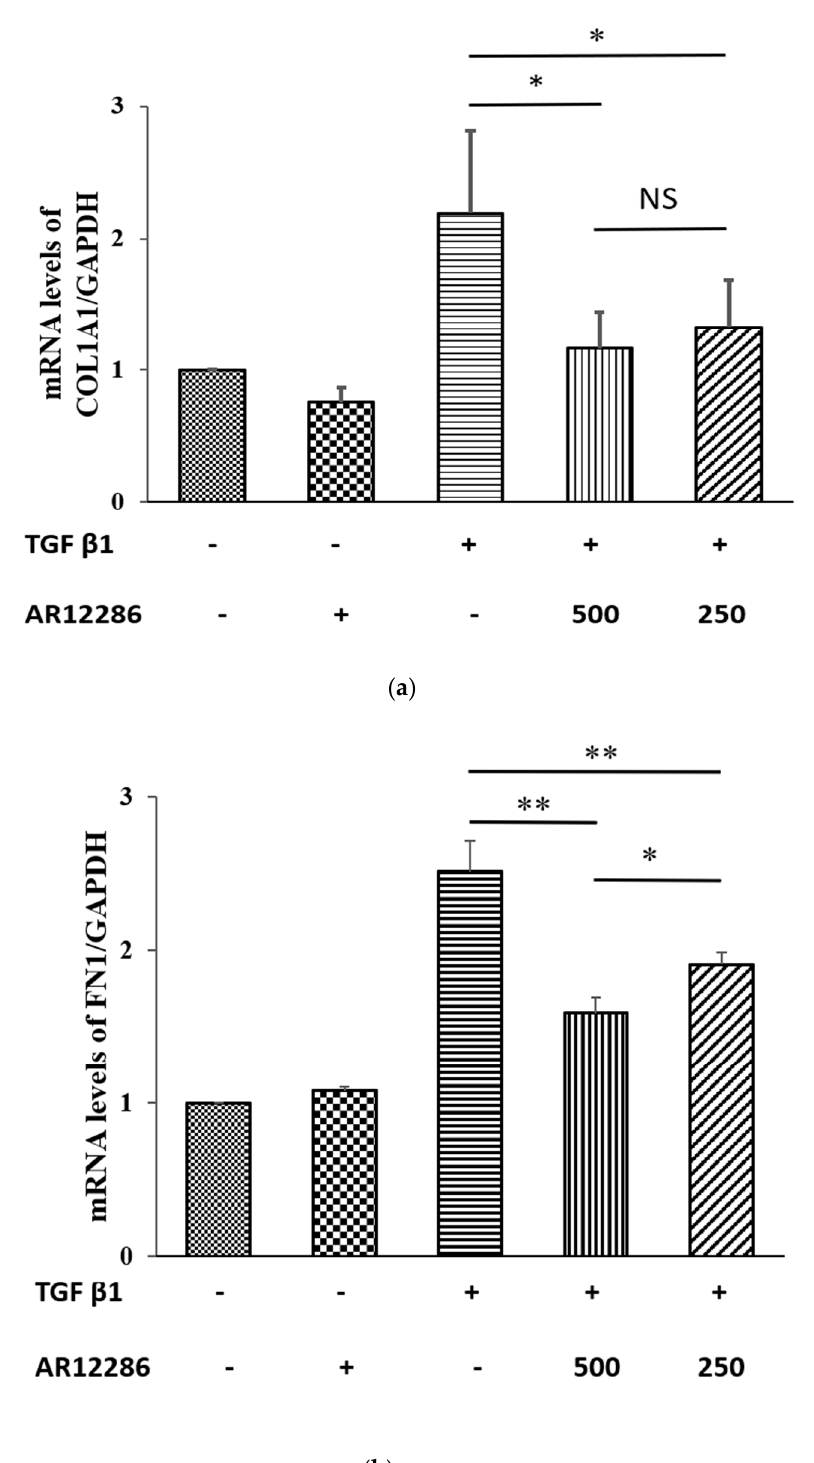
Figure 7. Effect of AR12286 on ( a ) COL1A1 and FN 1 ( b ) gene expression. AR12286 did not affect COL1A1 and FN 1 expression. However, TGF- β 1 significantly increased COL1A1 and FN 1 production. TGF- β 1-induced production of COL1A1 and FN 1 inhibited by AR12286. Data presented as means ± SEM ( n = 6). Asterisks indicate significantly different responses: **, p < 0.01; *, p < 0.05. NS signifies no significant difference.